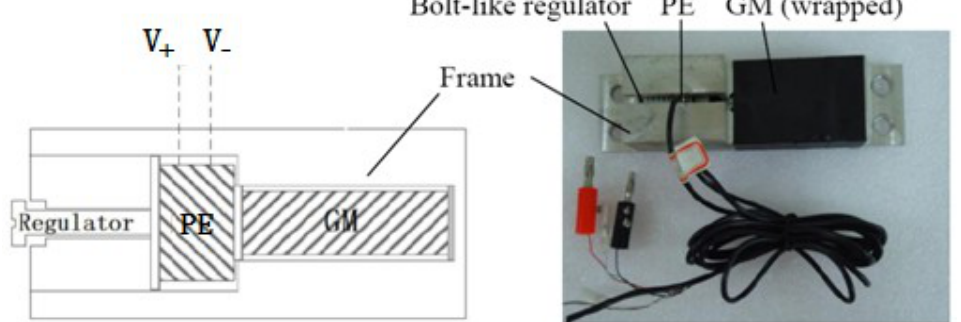
Figure 1. The schematic diagram and the prototype photograph of the non-contact displacement